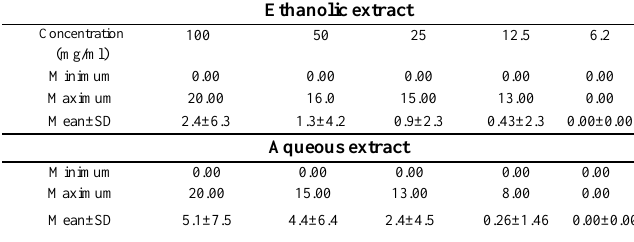
Table 1: Means of inhibition growth diameter of E ethanolic and Aaqueous extract of L. sativum against Mmulti drug resistant Ps. Aaeruginosa.